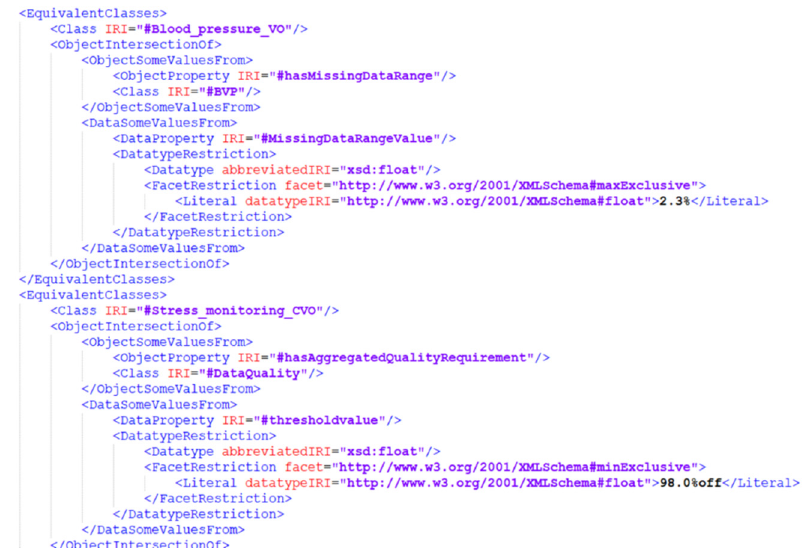
Figure 18. ASC CVO ontology OWL/XML code (excerpt view).